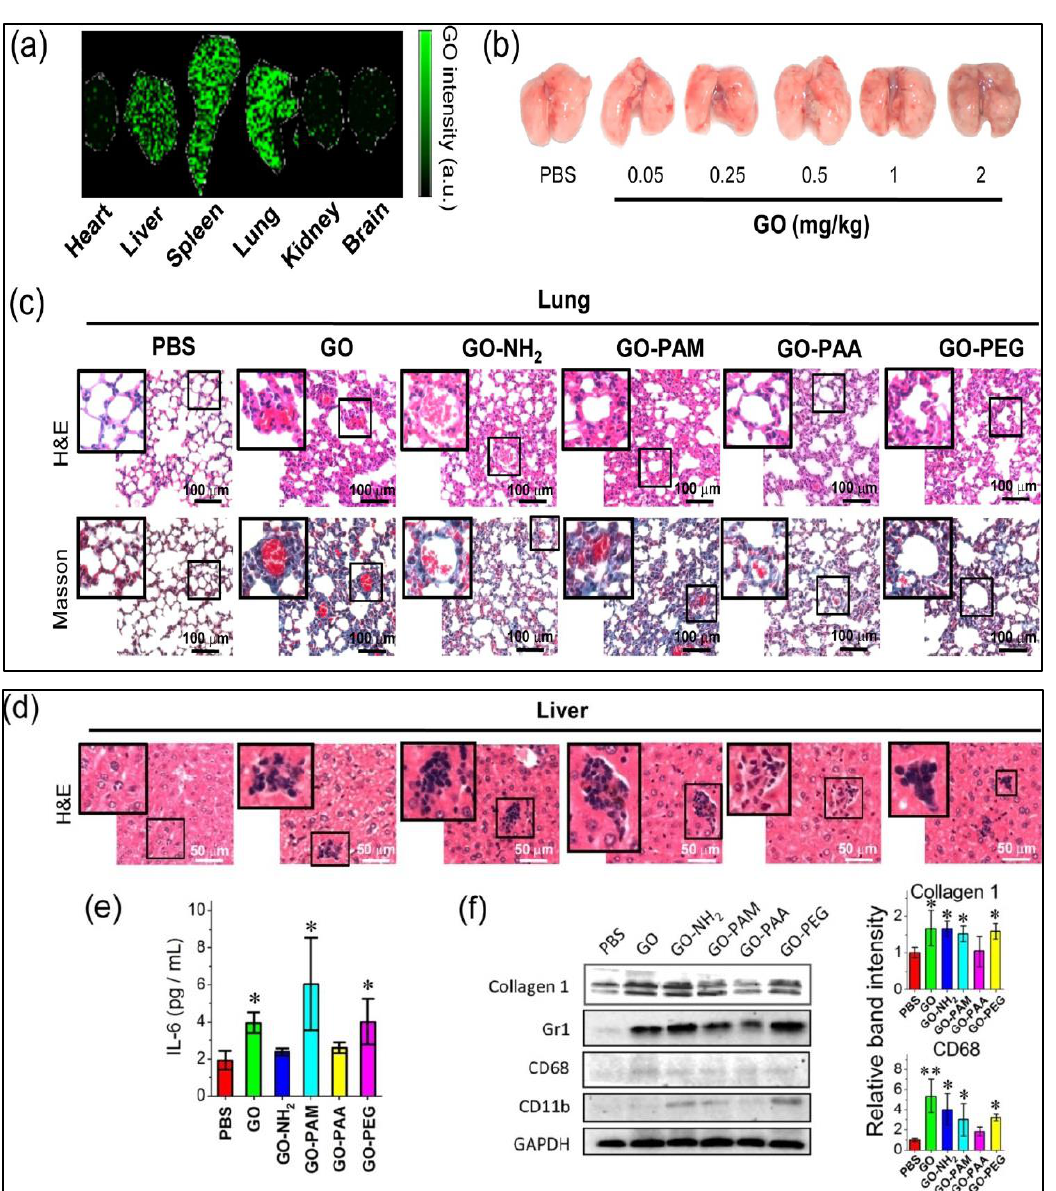
Figure 19. ( a ) Laser desorption/ionization mass spectrometry (LDIMS) image analysis showing biodistribution of GO in mice treated with GO (2 mg/kg body weight) for one day. ( b ) Images of mice lungs after treating with GO at 0.05, 0.25, 0.5, 1, and 2 mg/kg body weight for 1 day. Histological images of ( c ) lungs stained with H&E and Masson’s trichrome and ( d ) livers with H&E from mice injected with 1 mg/kg GO for 14 days. Magnified images from the line squares are the enlarged pulmonary alveoli. Dark spots are GO-cell complexes in livers. For Masson’s trichrome staining, blue color reveals collagen in lung. ( e ) IL-6 levels in sera from mice treated with a dose of 1 mg/kg body weight for 1 day ( n = 5). ( f ) Protein markers of collagen 1, Gr1, CD68, and CD11b measured by Western blot analysis in lungs from mice treated at 1 mg/kg body weight for 14 days. Quantified data are depicted in the right panel ( n = 4). * and ** imply p < 0.05 and p < 0.005 as compared to PBS-treated mice. Reproduced from [119] with permission of The American Chemical Society.